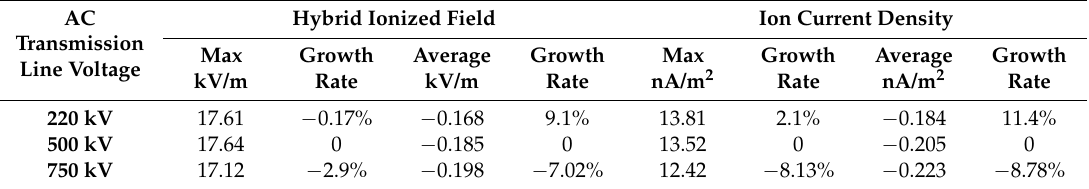
Figure 10. Comparison of calculation when the AC voltage is changed. ( a ) Hybrid ionized field. ( b ) Ion current density. Table 2. The value and growth rate of calculation results when the AC voltage is